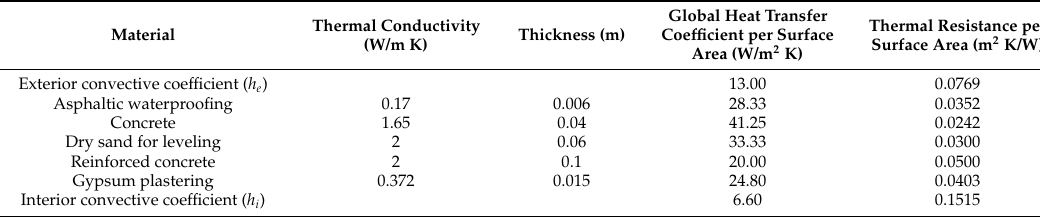
Figure 8. Roof insulation required to comply with NOM-020 in Hermosillo, Son. Table 2. Thermal resistivity of a slab